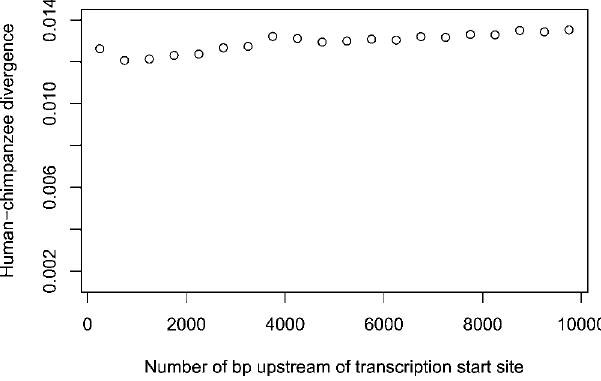
Figure 3. Human–Chimpanzee Divergence in 500-bp Blocks over Our 10- kb Upstream Noncoding Sequences Y axis range is the same as in Figure 1. DOI: 10.1371/journal.pcbi.0010073.g003 PLoS Computational Biology |